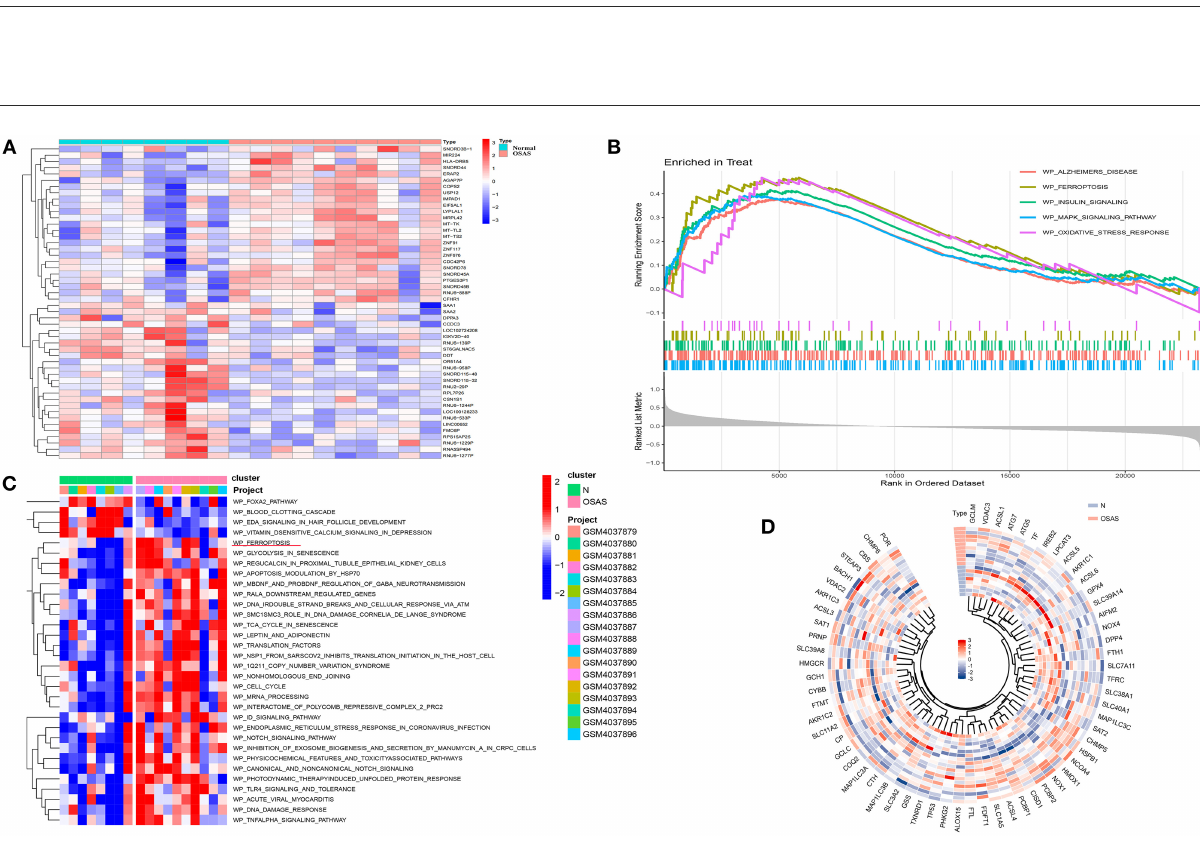
FIGURE2 Identification of the DEGs in the GSE135917 dataset, GSEA analysis, and GSVA heatmap analysis. (A) Heatmap plot of the DEGs for OSAS vs. controls. (B, C) GSEA and GSVA analysis in wikipathways for OSAS vs. controls. (|NES| > 1, FDR < 0.1, P- value < 0.05). (D) Ferroptosis genes ring